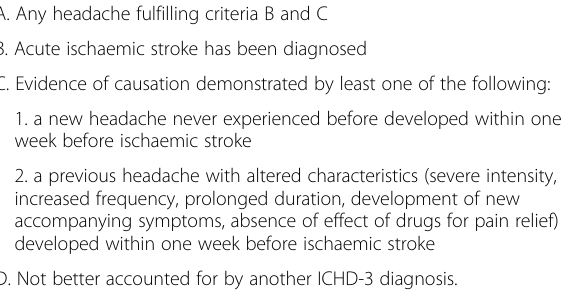
Table 7 Diagnostic criteria for sentinel headache before ischemic